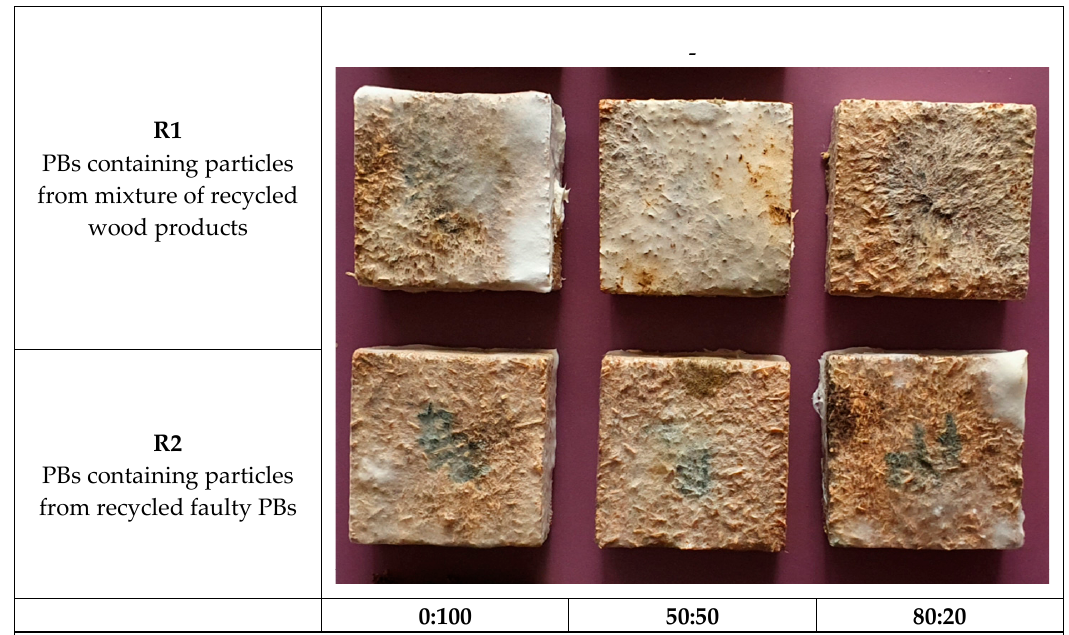
Figure 9. Growth of the surface mycelia of the brown-rot fungus Coniophora puteana on the top surfaces of PBs containing particles from recycled wood after 16 weeks of the decay